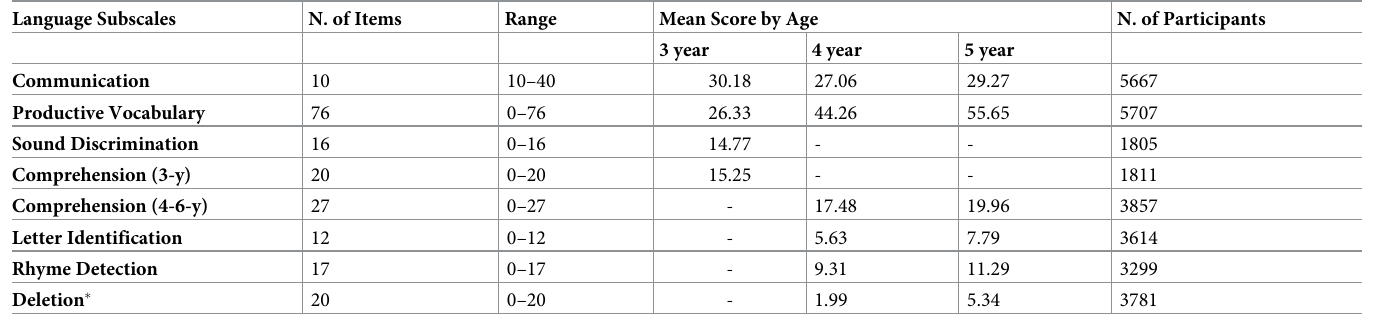
Table 1. Number of items, score range, mean score and number of participants for each language